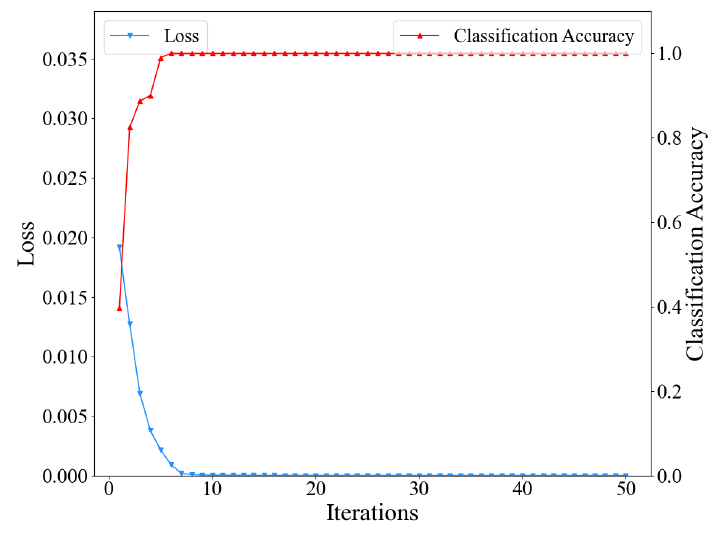
Figure 11. The results of model training on DUT